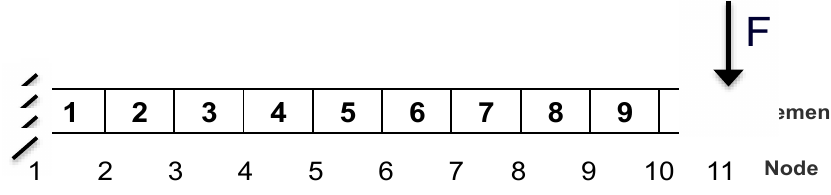
Figure 2. A schematic diagram of the cantilever beam. Table 1. Damage scenarios for the noisy free condition.